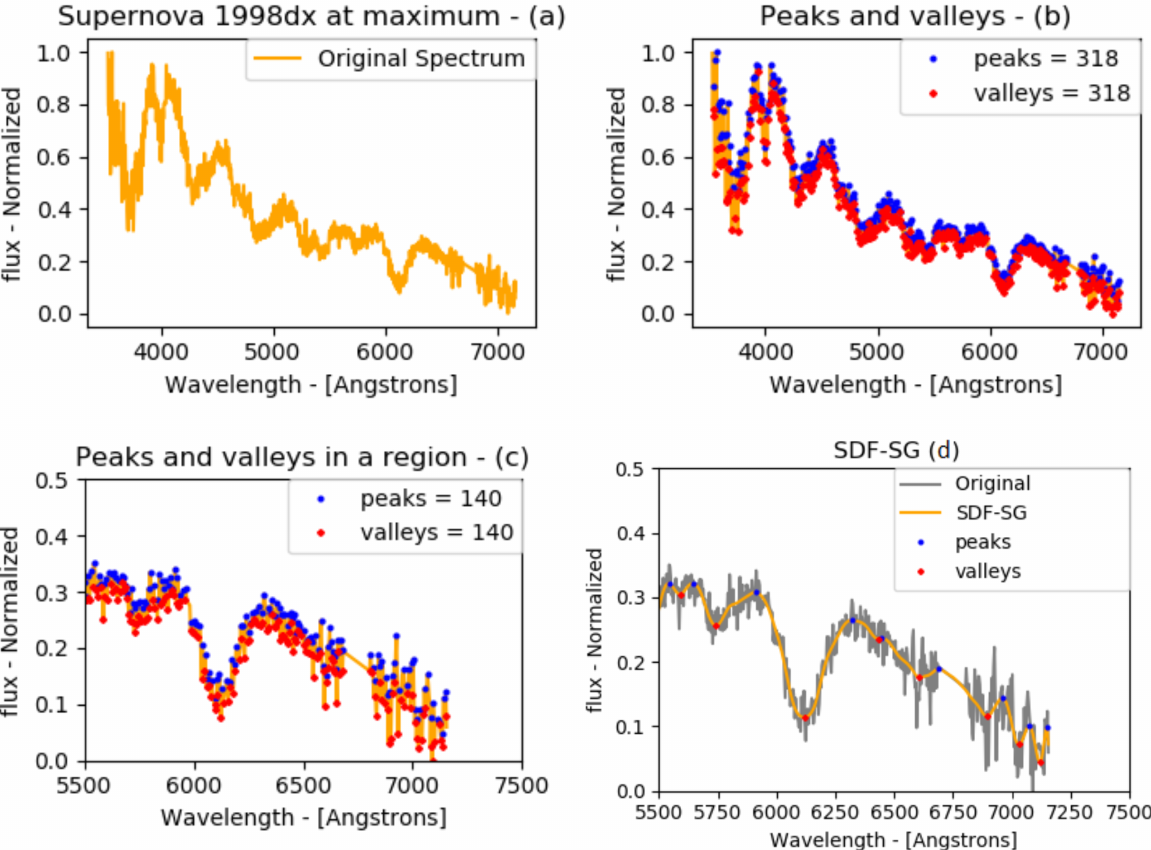
Figure 2. SDF-SG operation. Adapted from Arantes Filho et al. (2019). In (a) we show a raw SNIa spectrum, in (b) we made a search for the peaks and valleys (absorption and emission lines) of this spectrum. In (c) we show a region of this spectrum that shows a large number of peaks and valleys in a noisy area. In (d) we show this same region with the treatment by the SDF-SG system that reveals only the real peaks and valleys of the supernova